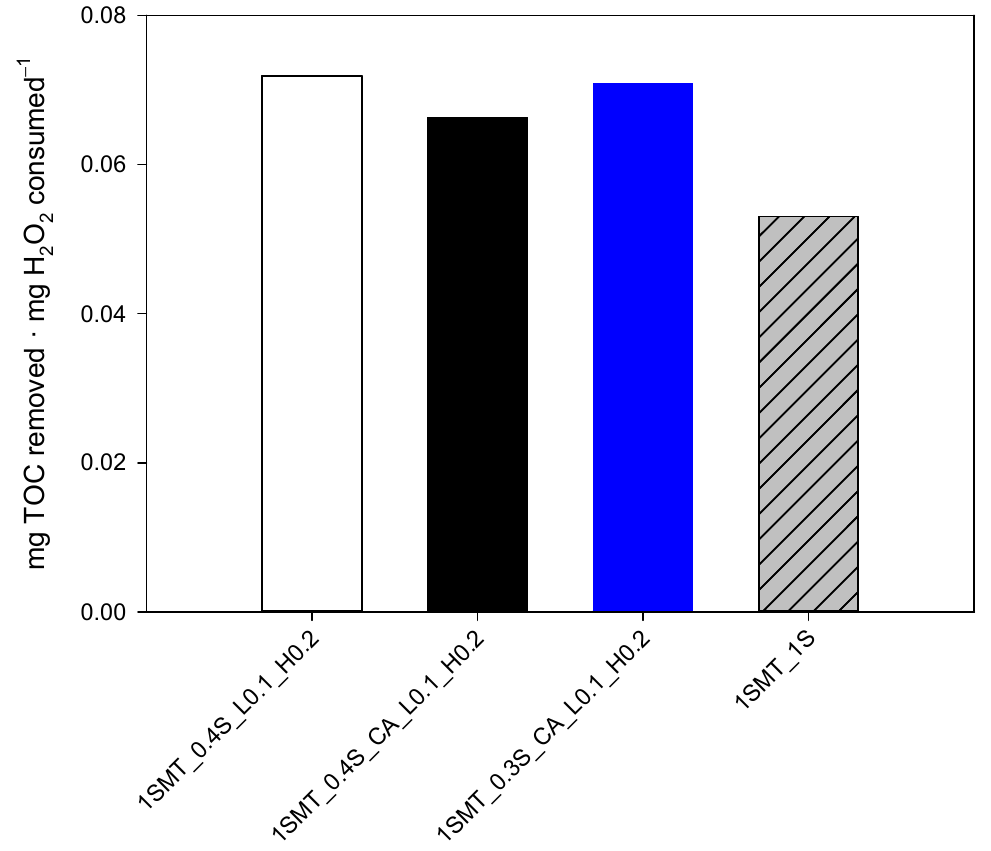
Figure 10. Comparison of the photo-Fenton process efficiency in terms of mg of TOC removed per mg of H 2 O 2 consumed for each dosage strategy, including the one-shot initial addition of the theoretical stoichiometric concentration.